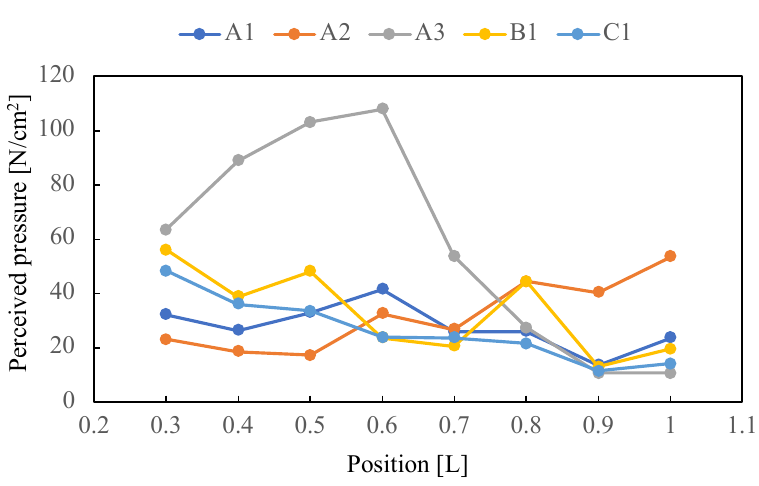
Figure 12. Perceived pressure distribution.